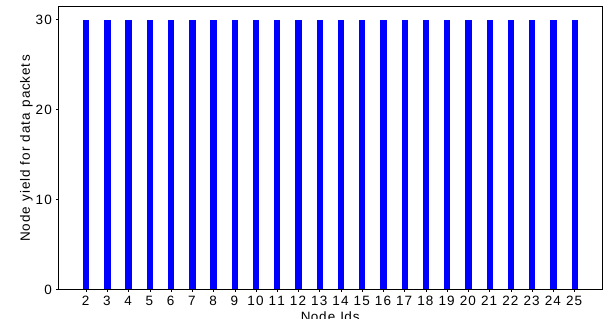
Figure 25. Node yield for test case 2 in each round. Note that the node yield plots for all the three rounds in test case 2 are the